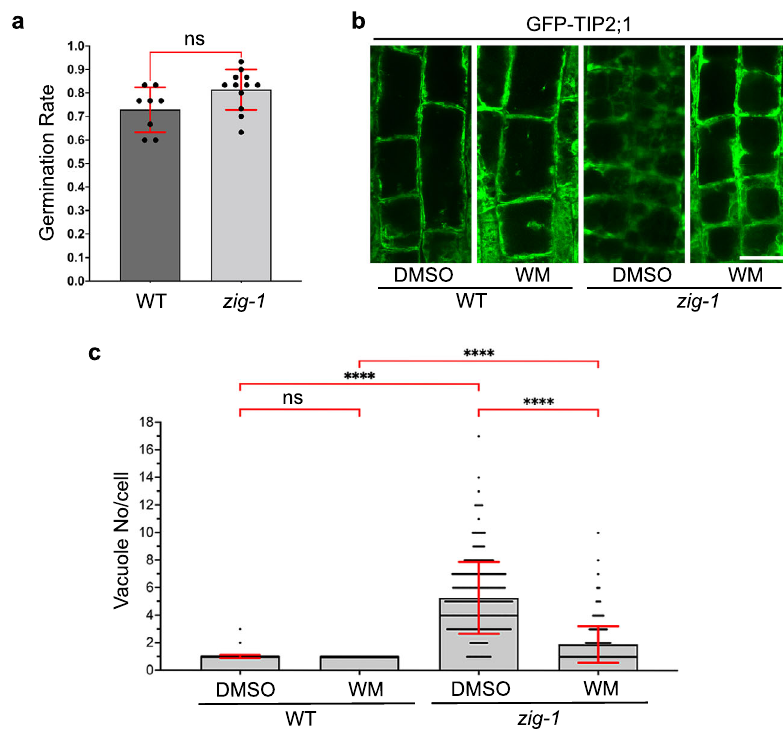
Fig. 2 The WM-induced vacuole fusion assay can be carried out in the BRIC-PDFU. a Germination rate of WT and zig-1 seeds inside BRIC- PDFU during EVT. No signi fi cant difference in germination rate between two genotypes was detected after removing the two WT outliners (30% and 50%). (Unpaired t -test, ns: p > 0.05; n represents plate number, n > = 8). b Fixed root tip cortex cell vacuole morphology of WT and zig-1 (GFP-TIP2;1). Three-day-old WT and zig-1 seedlings were treated with DMSO buffer control or WM solution for 2 h and then seedlings were fi xed and kept at 4 °C before confocal imaging. Scale bar: 20 μ m. c Quanti fi cation of vacuole number in WT and zig-1 after chemical treatment. Cells from the cortex transition zone of the root tip were analyzed. (Two-way ANOVA, Tukey ’ s multiple comparison test, **** p < 0.0001; n represents cell number under analysis for each genotype with each treatment, n > 365). Raw datapoints are represented with fi lled circles. Error bars represent standard